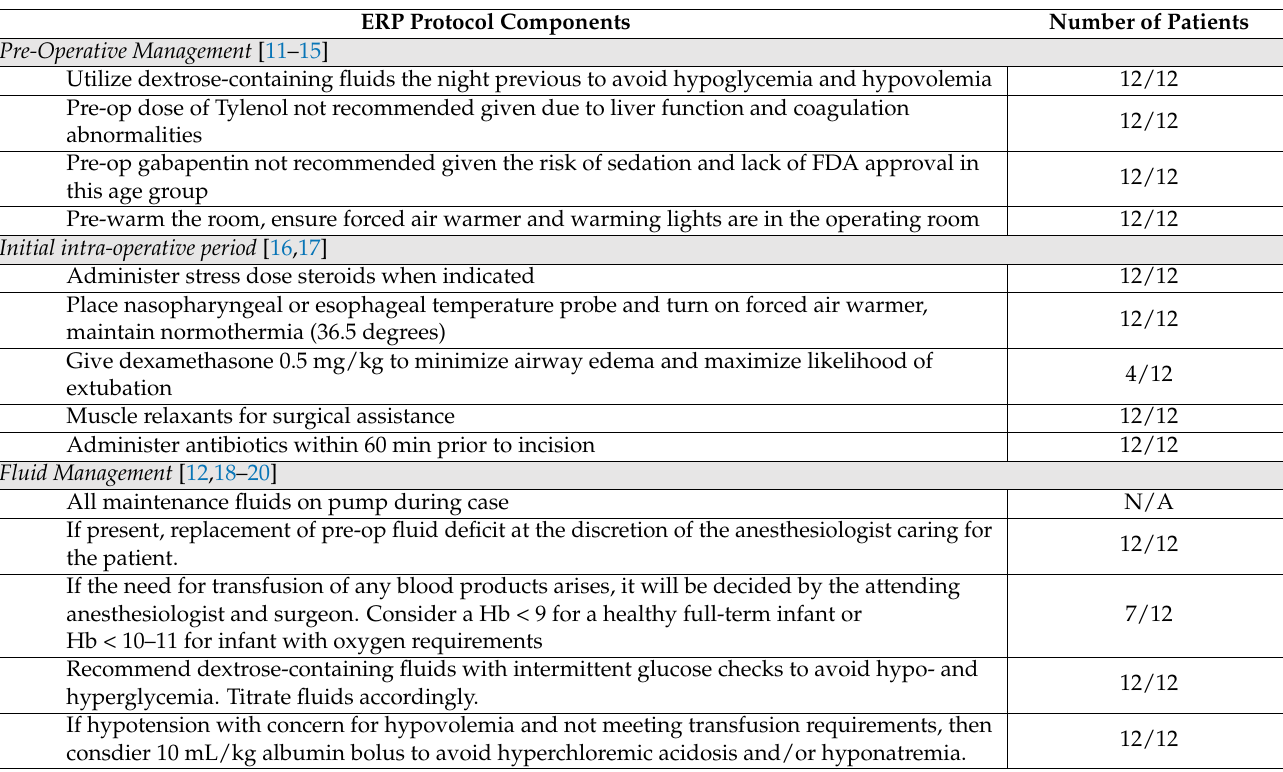
Table 1. ERP Protocol Component